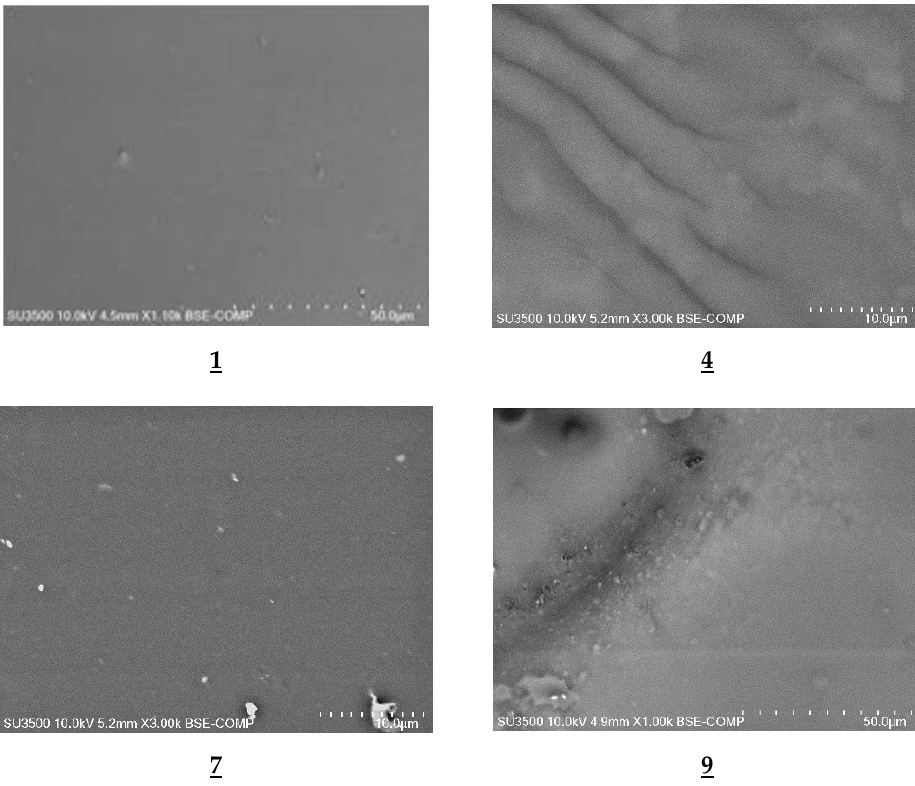
Figure 3. SEM images of PIMs containing 1-alkyl-triazole 1 , 4 , 7 , 9 as a carrier. The roughness (R q ) parameter of the membrane is the standard deviation of the z values within the box cursor and was calculated using atomic force microscopy (AFM) from Formula (14) and is presented in Table 6.